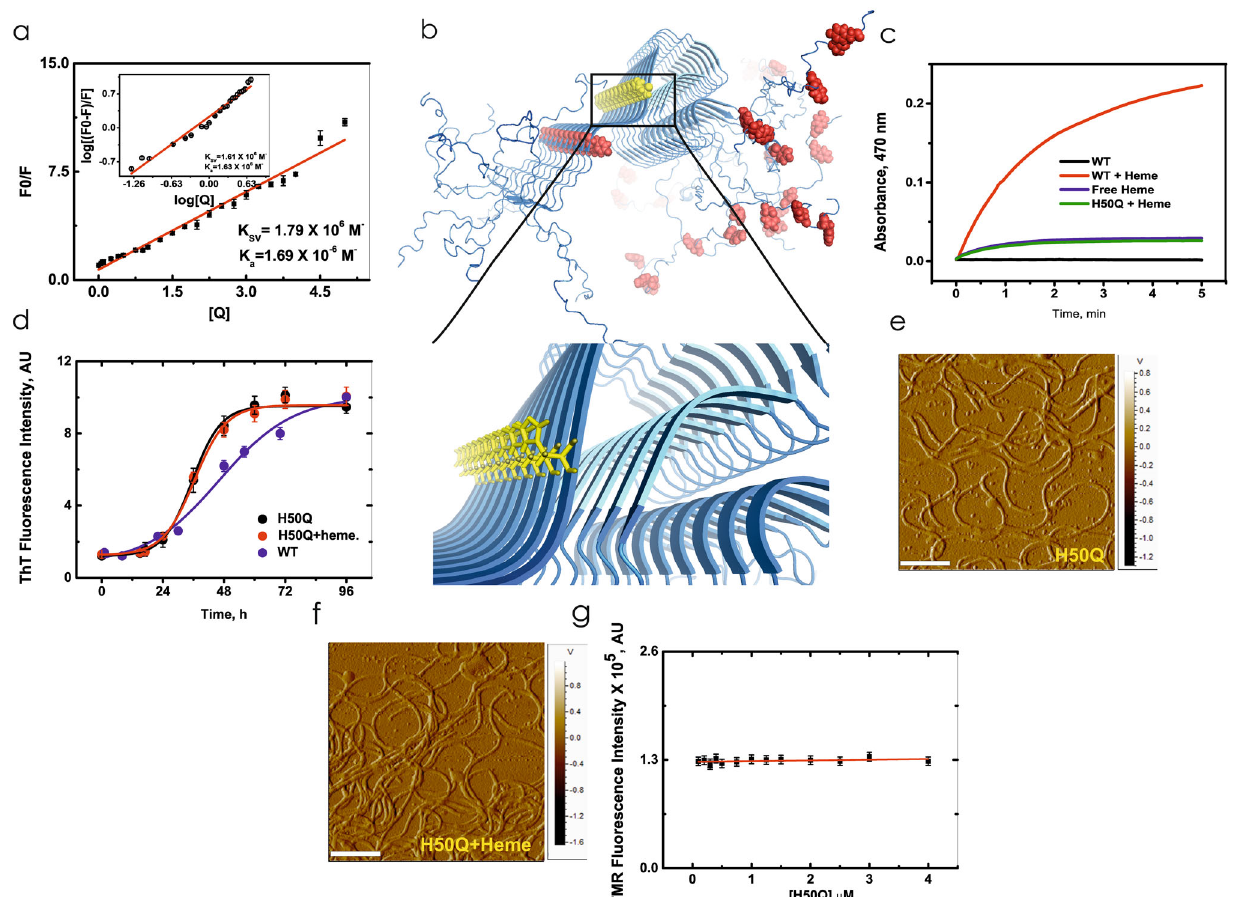
Fig. 5 Heme binds to the His50 residue on α -Syn forming a peroxidase-positive complex. a Stern-Volmer plot and double log plot (inset) obtained from the steady-state quenching and binding of TMR-5-maleimide-tagged α -Syn-G132C with heme, K D = 0.591 μ M (datasets = 6). b Greek-key β - sheet alignment of the fi bril core with the potential heme-binding residues (Tyr: in red; His: in yellow). Inset shows magni fi ed view. c Kinetic traces for peroxidase activity monitored for the α -Syn WT-heme complex (datasets = 3). d The aggregation behaviour of the histidine mutant H50Q is unaltered in presence of heme as observed using ThT fl uorescence. e – f AFM micrographs depict that H50Q aggregates into fi brils even in the presence of heme. Scale bars represent 500 nm. g The H50Q mutant shows no binding with heme, as observed from the absence of any quenching of TMR-tagged H50Q/G132C by heme (datasets = 3). All error bars are ±SEM.